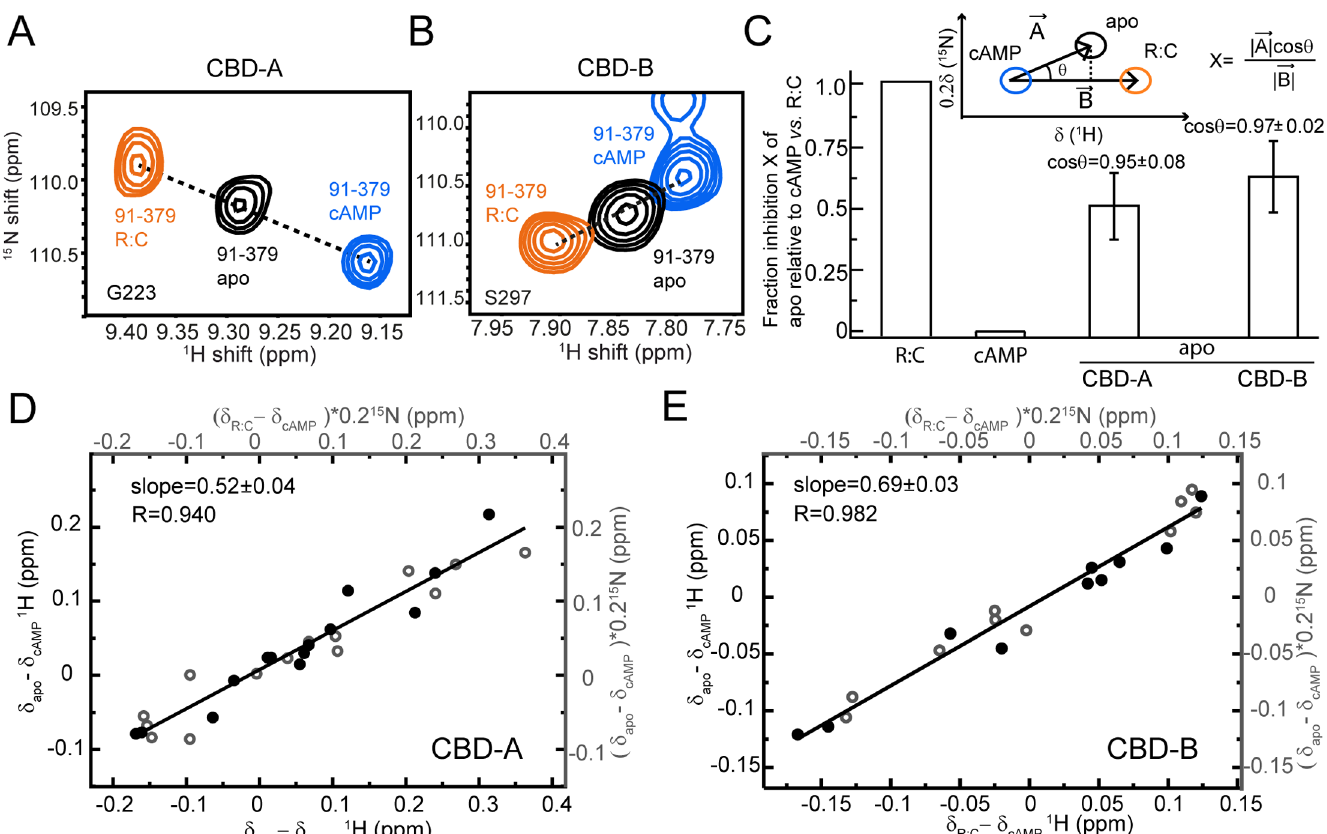
Fig 2. Conformational selection in CBD-A and -B of RI α (91 – 379). (A, B) Overlay of apo, cAMP 2 -bound, and C-bound RI α (91 – 379) for cross-peaks of representative residues sensing the active versus inactive equilibria in CBD-A (A) and CBD-B (B). (C) Fractional inhibition of apo RI α (91 – 379) (X) relative to cAMP 2 - and C-bound RI α (91 – 379), assuming they represent the active and inactive forms of PKA, respectively. The inset illustrates how X was measured using the CHEmical Shift Projection Analysis (CHESPA) method. The bar graph shows the average X values observed for residues in CBD-A and -B exhibiting a linear pattern (|cos θ | > 0.95). (D) Alternative evaluation of the fractional inhibition of apo RI α (91 – 379) (X) through the slope of the ( δ apo − δ cAMP ) versus ( δ C − δ cAMP ) plot, where δ apo , δ cAMP , and δ C are the chemical shifts of apo, cAMP 2 - and C-bound RI α (91 – 379). Closed and open circles indicate 1 H and 15 N chemical shifts, respectively. This plot was restricted to CBD-A residues that are sufficiently removed from the cAMP-dependent interfaces (e.g., R: C, R:cAMP and CBD-A:CBD-B) to report primarily on the active versus inactive equilibrium of CBD-A. (E) Similar to panel (D) but for